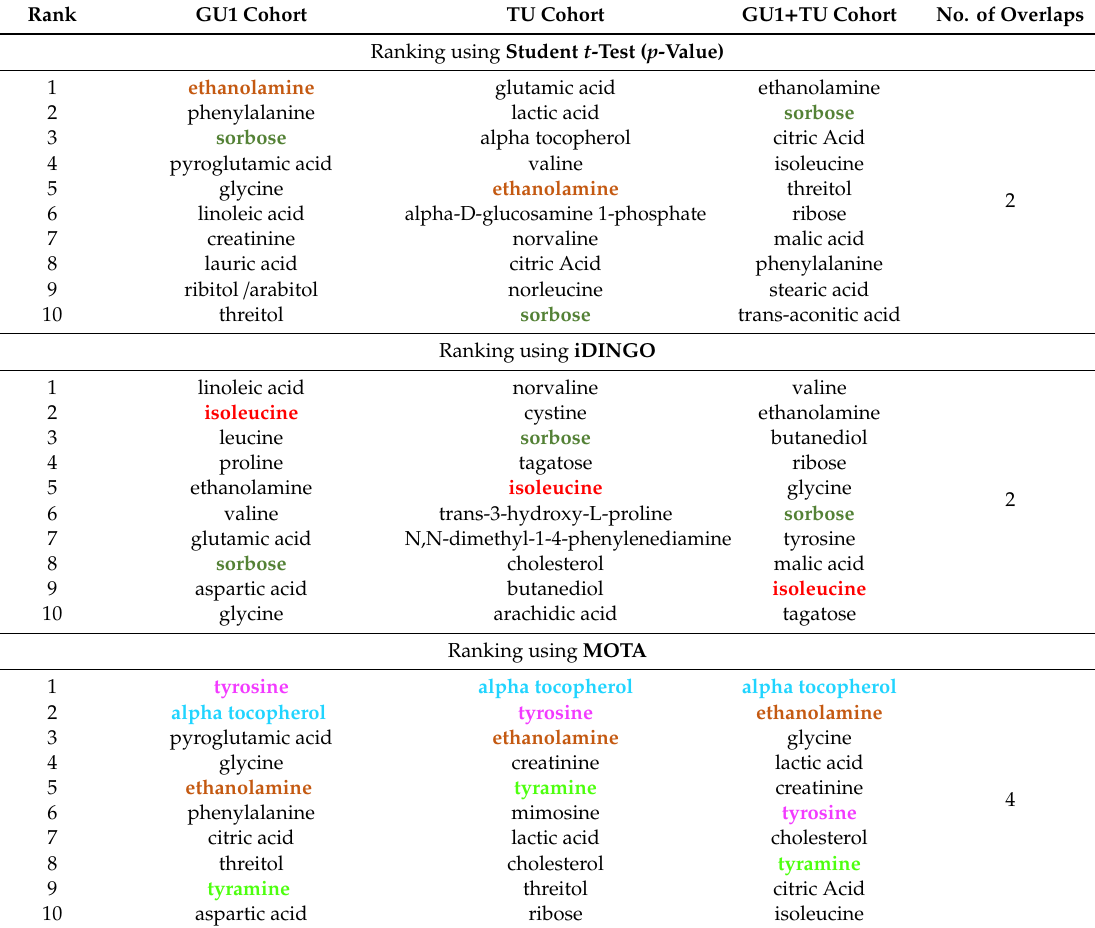
Table 3. Biomarker candidates overlapping between the GU1, TU, and combined TU and GU1 datasets ranked by t -test, iDINGO, and